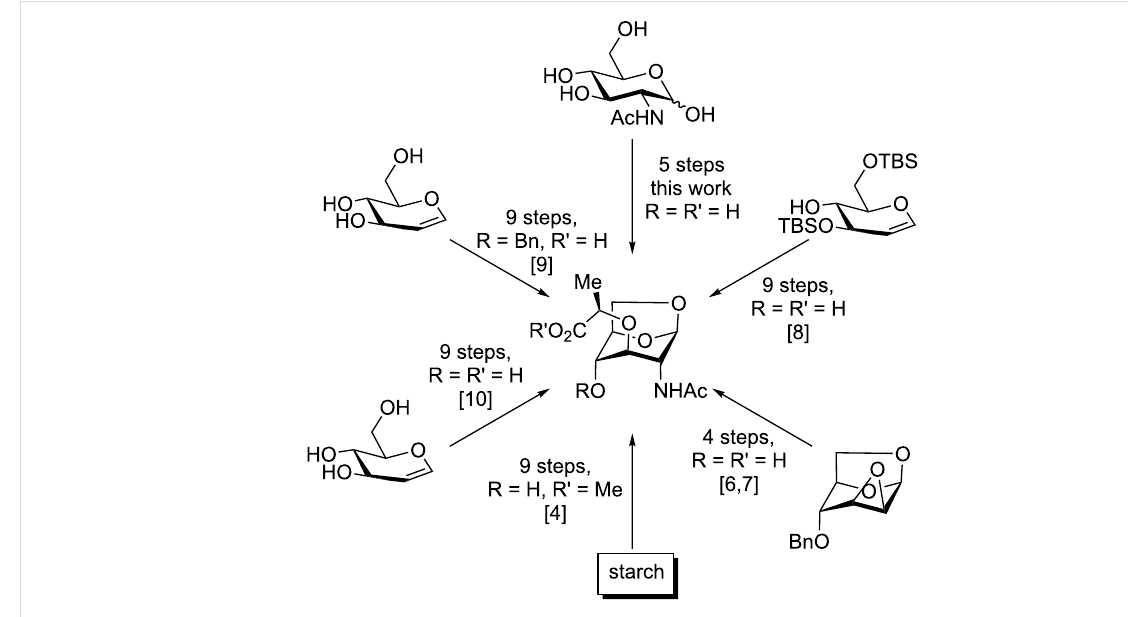
Scheme 1: Our approach to AnhydroMurNAc compared with literature preparations.